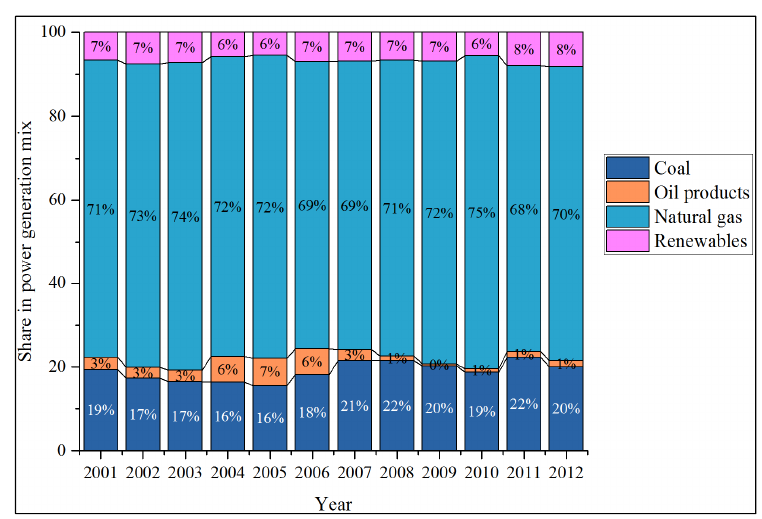
Figure 17. Singapore: power generation mix.